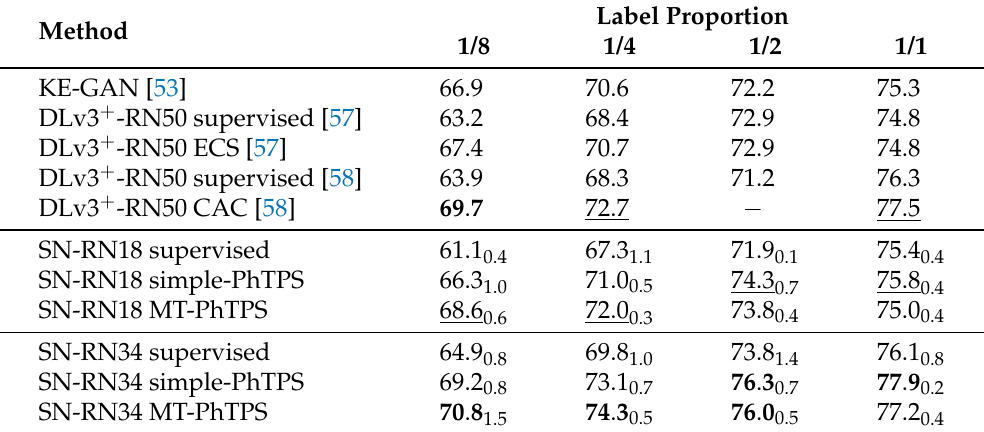
Table 3. Semi-supervised semantic segmentation performance (mIoU/%) on full-resolution Cityscapes val with different proportions of labeled data. We compare simple-PhTPS and MT- PhTPS (ours) with supervised training and previous work. DLv3 + -RN50 stands for DeepLab v3 + with ResNet-50, and SN for SwiftNet. We run experiments across 5 different dataset splits and report mean mIoUs with standard deviations. Best results overall are bold, and best results within sections are